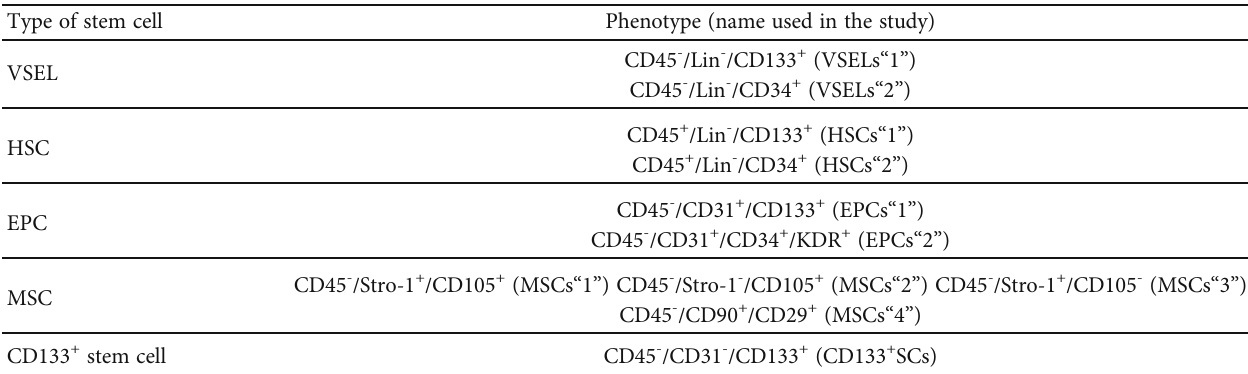
Table 1: Analyzed BMSC populations and their corresponding phenotypes. EPC: endothelial progenitor cell; HSC: hematopoietic stem cell; MSC: mesenchymal stem/stromal cell; VSEL: very small embryonic-like stem